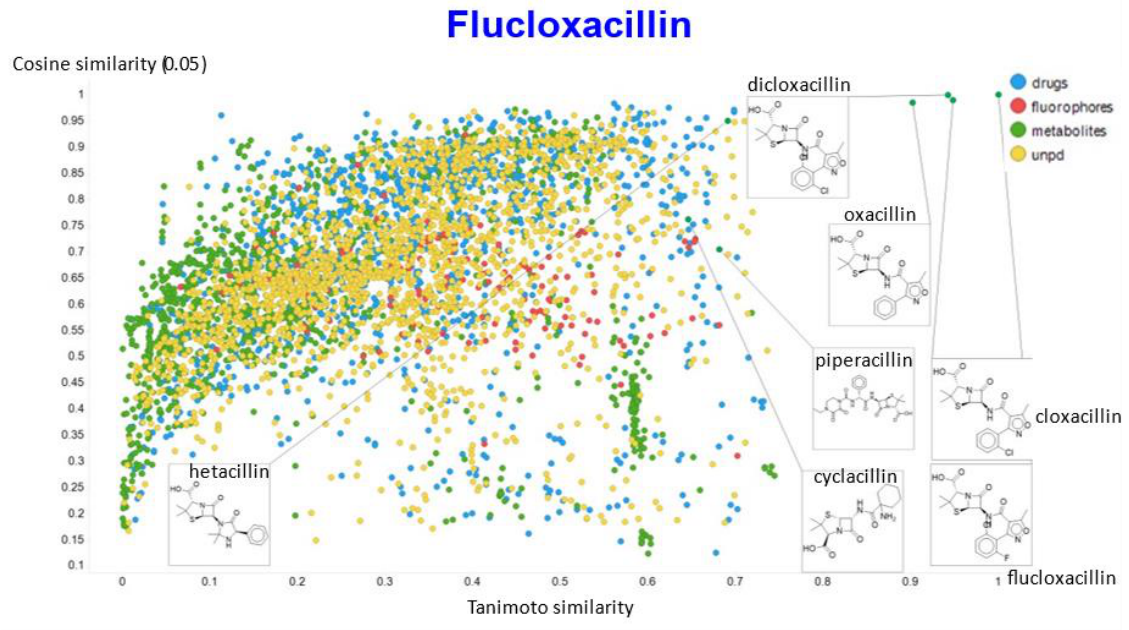
Figure 14. Relationship between cosine similarity and Tanimoto similarity (temperature = 0.05) for flucloxacillin in our chemical space.